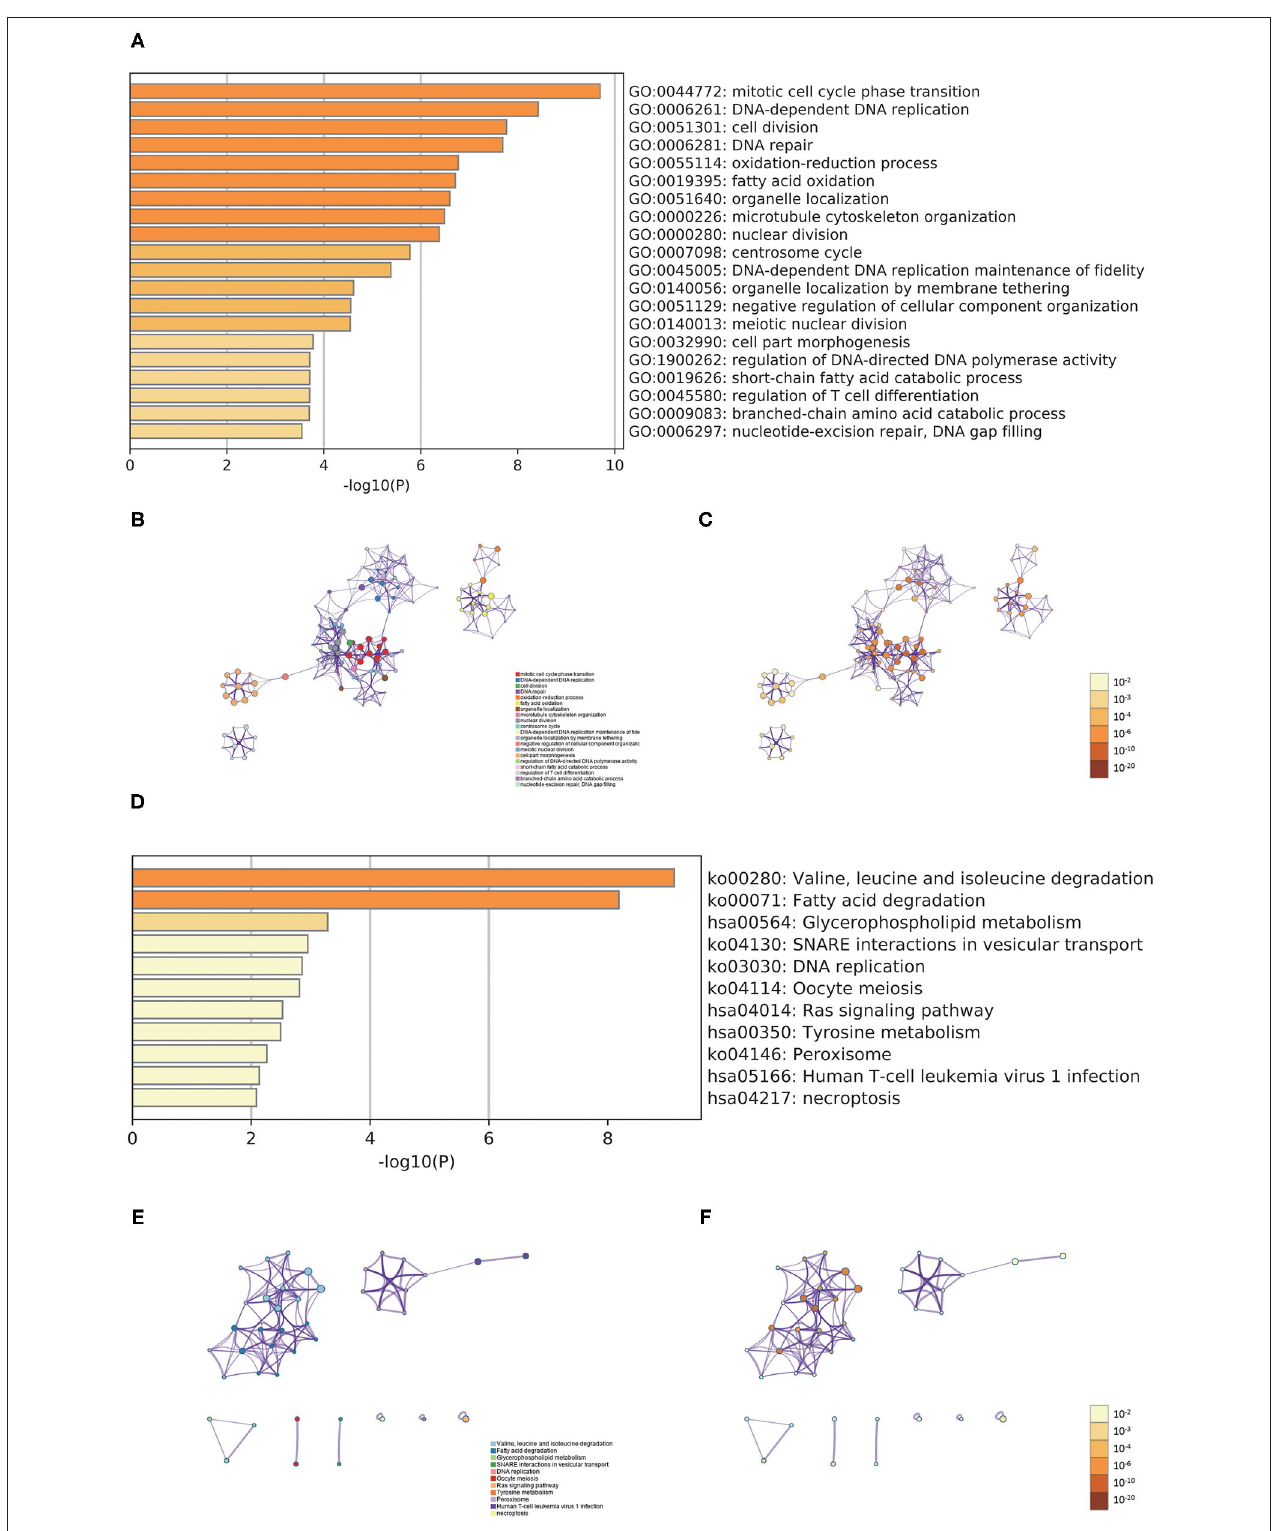
FIGURE 7 | Functional enrichment analyses. (A) Heatmap of the biological processes enriched terms; (B) network of biological processes enriched terms; (C) network of biological processes enriched terms; (D) heatmap of the pathways enriched terms; (E) network of pathways enriched terms; (F) network of pathways enriched